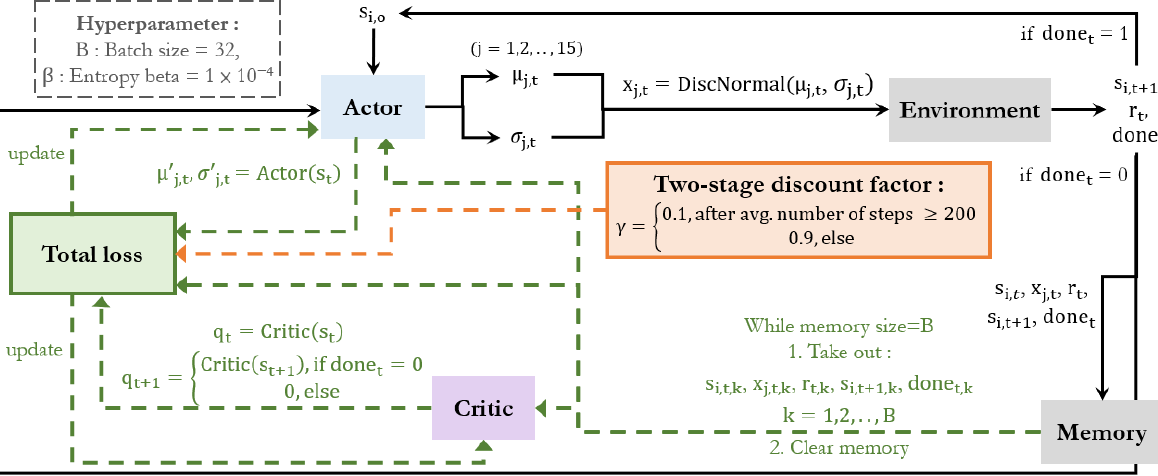
Figure 3. Proposed process diagram.